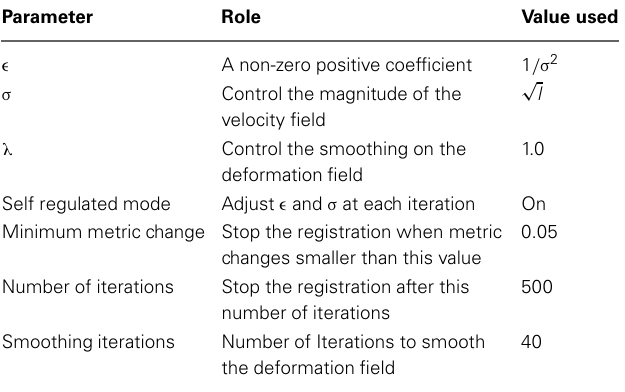
Table 3 | Parameters in spherical diffeomorphic demons registration.